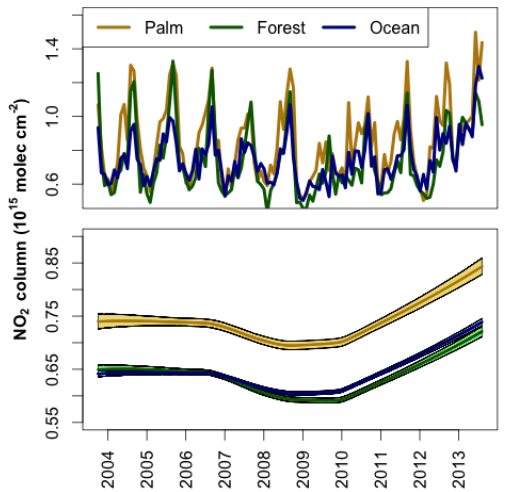
Figure 15. A monthly mean and LOWESS time series of HCHO from OMI in the three separate regions of northern Borneo (see Fig. 13). The LOWESS shaded regions represent the 95% confi- dence interval.